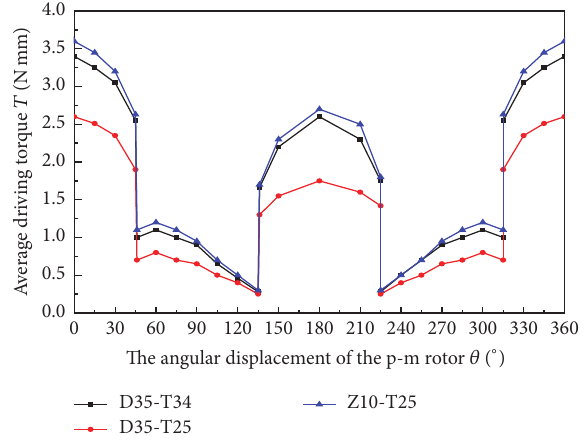
Figure 9: Average magnetic driving torque of two kinds of electro- magnet with the coil current